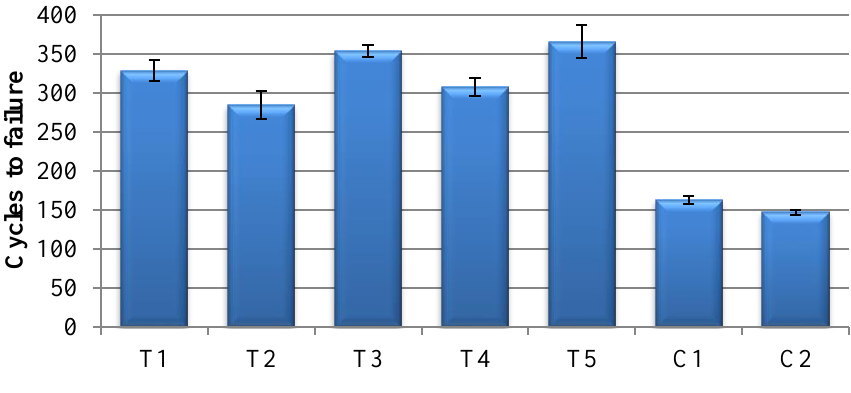
Figure 10. Thermo-cyclic fatigue lifetime results.